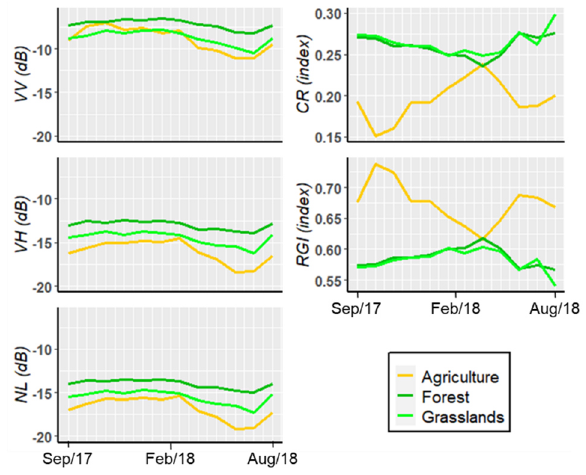
Figure 4. Composite of the SAR time series describing the monthly mean behaviour of the backscattering for the analysed classes, at different channels